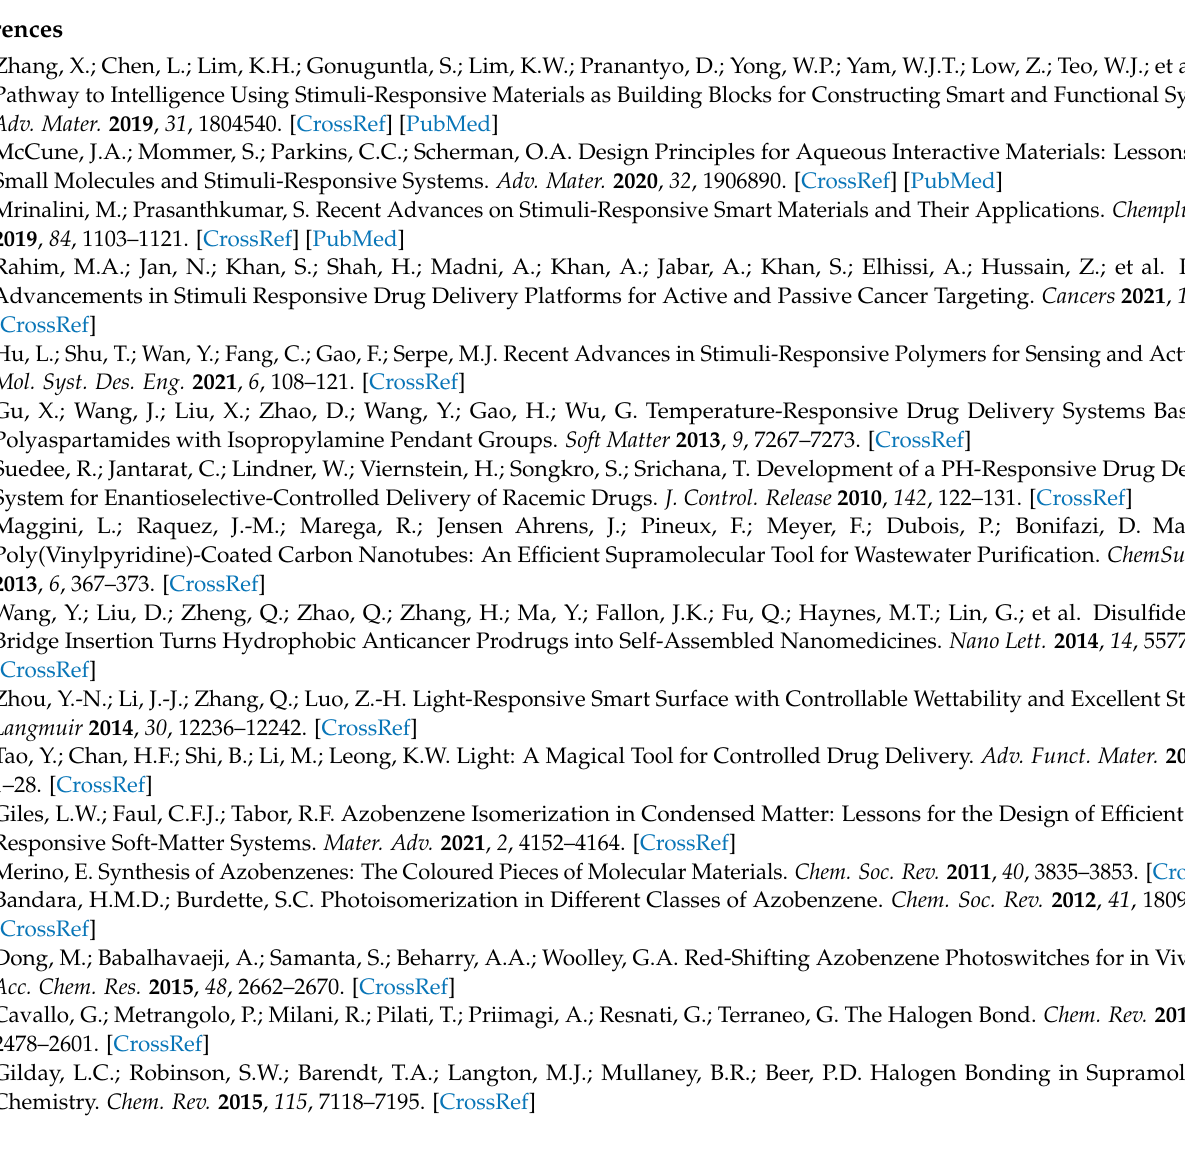
synthon. Halogen and hydrogen bonds are represented in blue and red dashed lines, respectively. Figure S8. 19 F NMR titration curves of I–azo–NO 2 ( A ), I–azo–NH 2 ( B ) and I–azo–NH–MMA ( C )